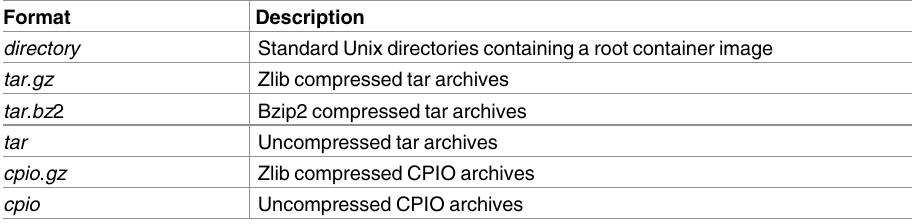
Table 2. Container formats